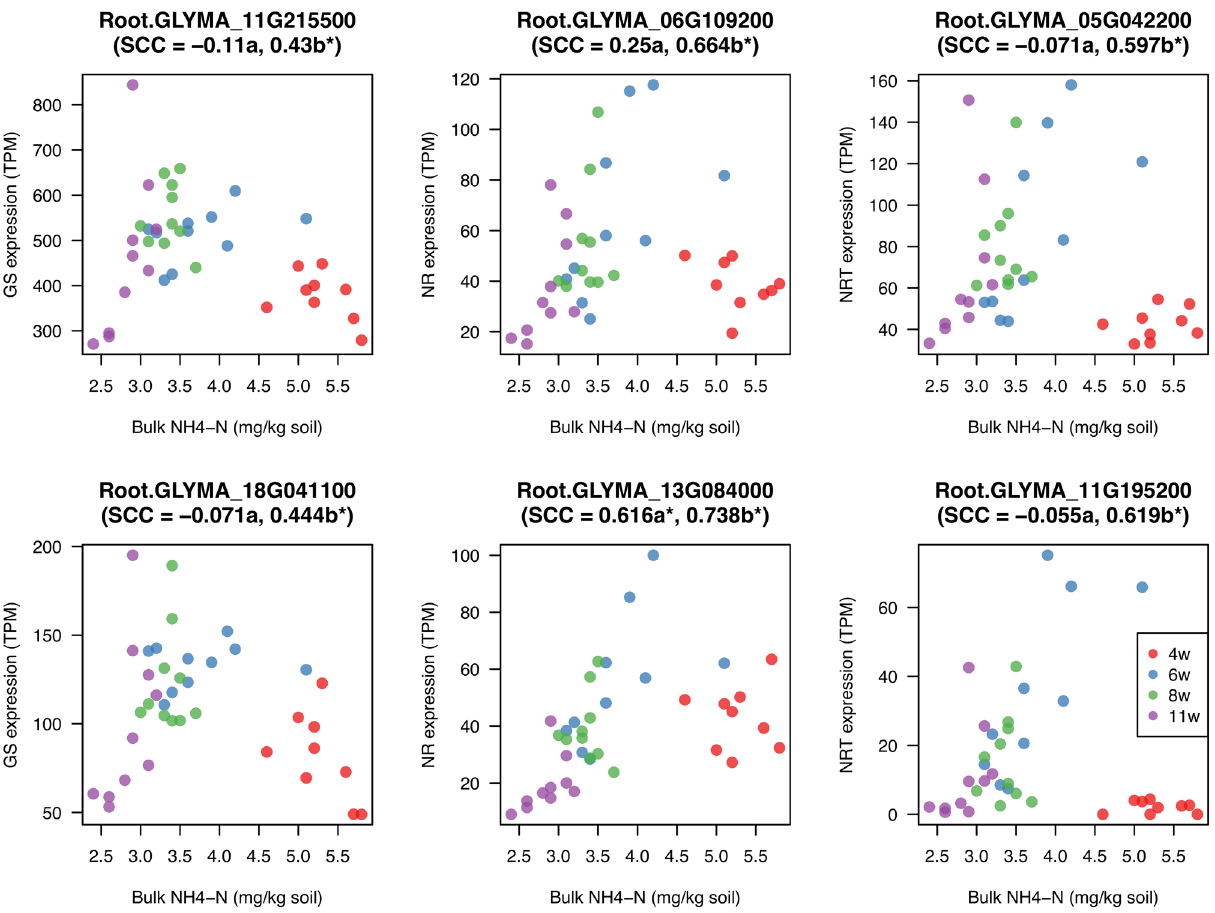
Figure 9. Correlation between the expression of nitrogen-responsive genes and the content of NH 4 –N in the bulk soil. Scatter plots of gene expression levels and NH 4 –N contents, and Spearman correlation coefficients (SCC). SCC values with “a” indicate correlation during 4–11 WAP and those with “b” during 6–11 WAP. Asterisks (*) show significant correlations ( p <